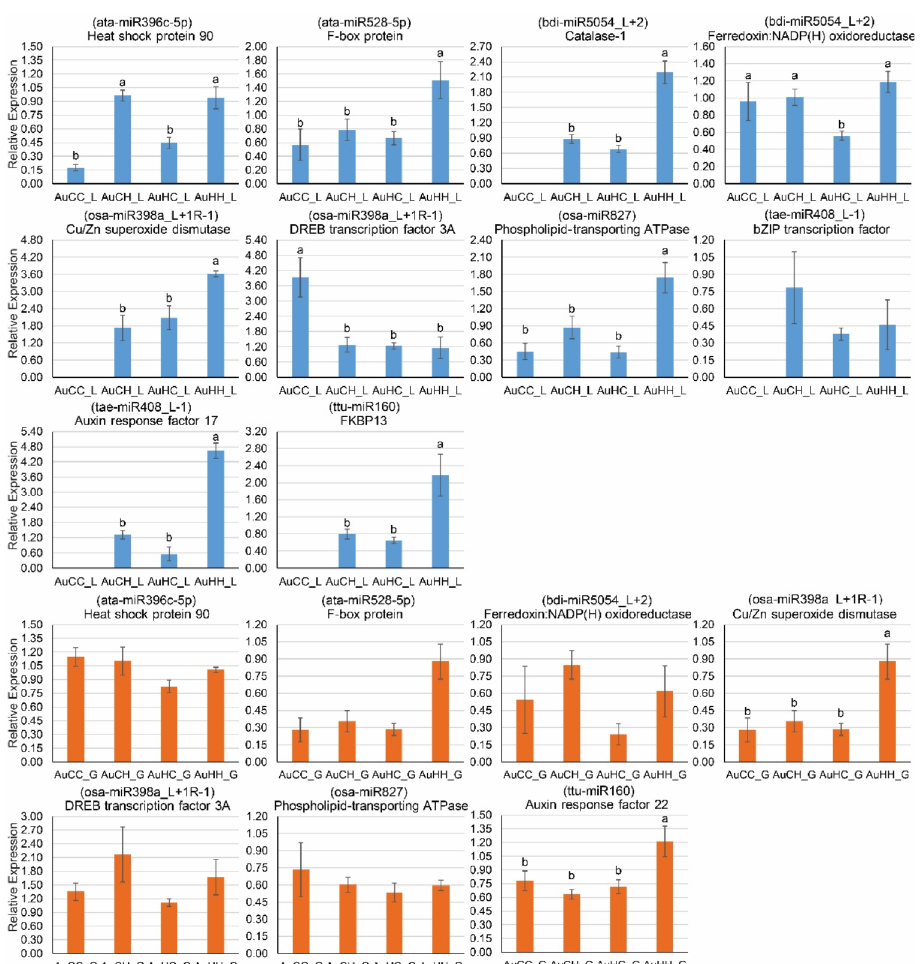
Figure 7. qPCR expression profile of 11 selected stress-responsive target genes in DBA Aurora. Relative miRNA expression was calculated using GAPDH as the housekeeping gene. Data are presented as the mean ± standard error (SE) ( n = 3). The treatment groups are: AuCC (DBA Aurora progeny treated with the control, originated from control group parents), AuCH (DBA Aurora progeny treated with heat stress, originated from control group parents), AuHC (DBA Aurora progeny treated with the control, originated from heat stress group parents), AuHH (DBA Aurora progeny treated with heat stress, originated from heat stress group parents). _L indicates flag leaf samples (highlighted in blue) and _G indicates developing grains samples (highlighted in orange). One-way ANOVA analysis was performed to identify statistical significance across treatment groups ( p < 0.05). Different letters (a, b, c) represent significant statistical difference across treatment groups based on the l.s.d value. FKBP13: peptidyl-prolyl cis-trans isomerase FKBP13, chloroplastic-like. The auxin response factor 22 (target of ttu-miR160) was not expressed in the flag leaf tissue. The catalase-1 gene (target of bid-miR5054_L+2), bZIP transcription factor (target of tae-miR408_L-1), auxin response factor 17 (target of tae-miR408_L-1) and FKBP13 (target of ttu-miR160) were not expressed in the developing